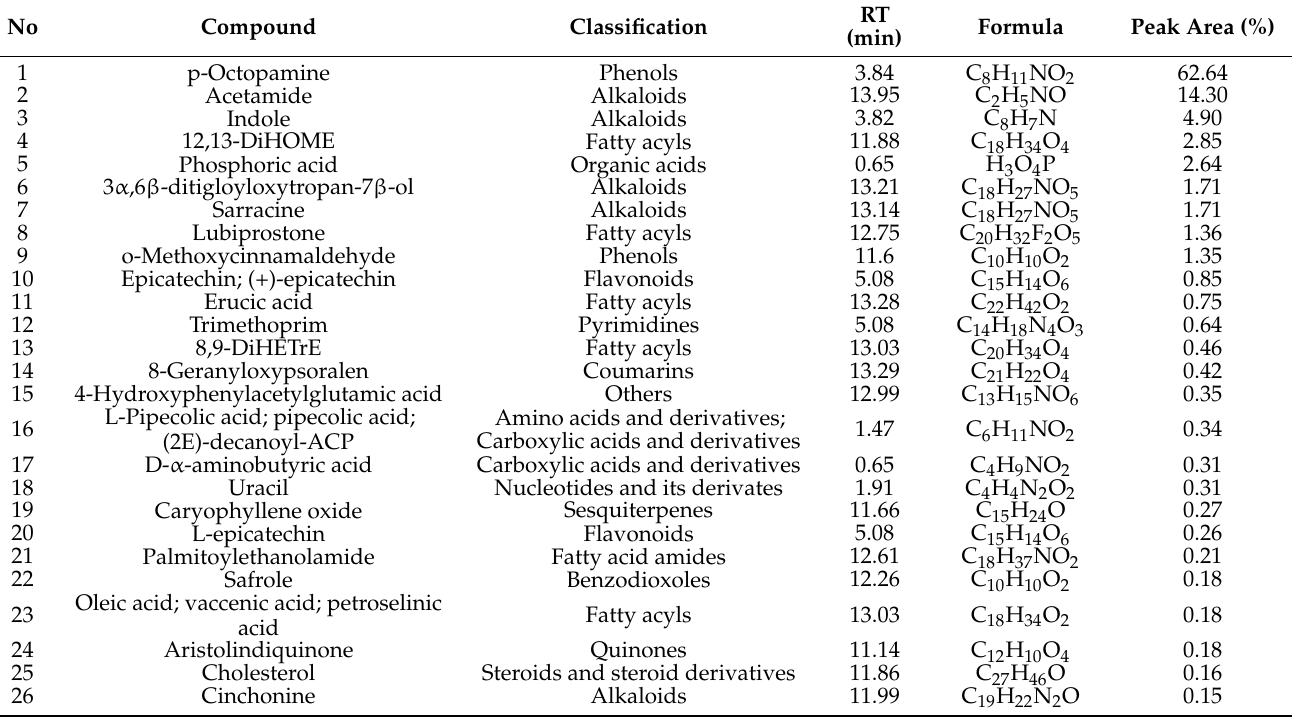
Table 4. Identification of potential antibacterial ingredients in Fraction 4 of the